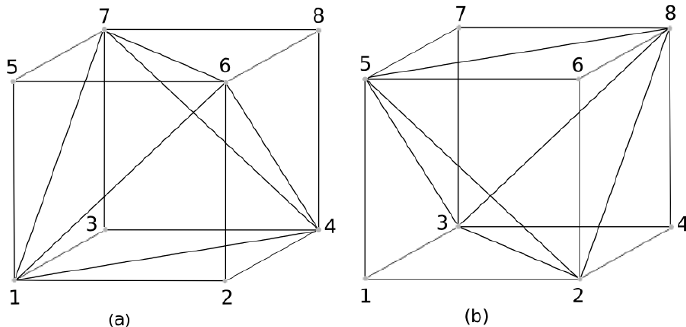
Figure 1. Decomposition of grid block into five tetrahedral